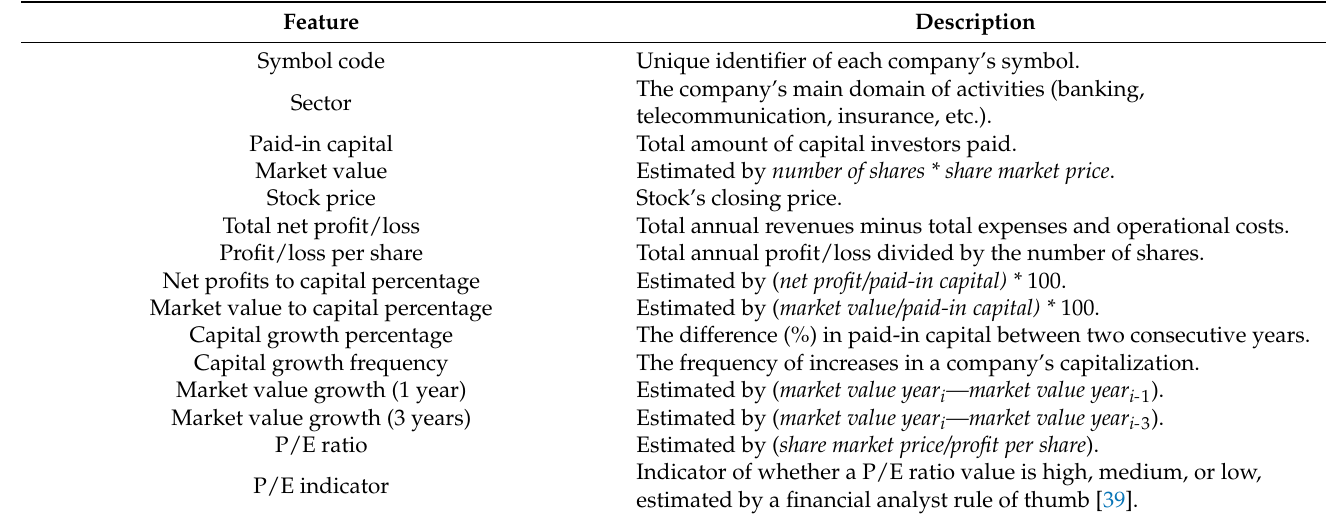
Table 2. A set of 15 features is generated for each year i (query) and stock symbol j